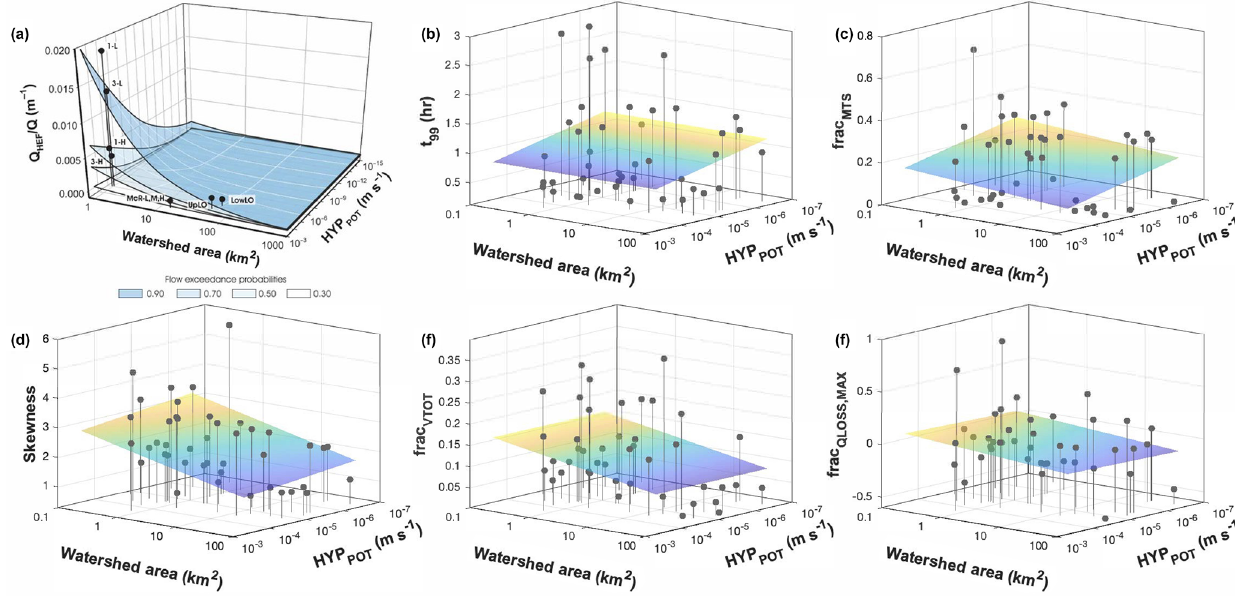
Figure 6. Comparison of (a) conceptual model of river corridor exchange (reprinted from Wondzell (2011) with permission) and findings from this study including a best-fit planar surface fit to the synoptic data for each panel (dots show the data points, and stems extend to the bottom X – Y plane to aid in visualization; planar surface light-to-dark shading indicates high to low for the z axis variable). Panels show trends for a subset of variables representing (b) experimental design, (c) separation of advection–dispersion from transient storage, (d) short-term storage, (e) StorAge Selection, and (f) long-term storage. Goodness of fit and slopes for each fit are summarized in Table